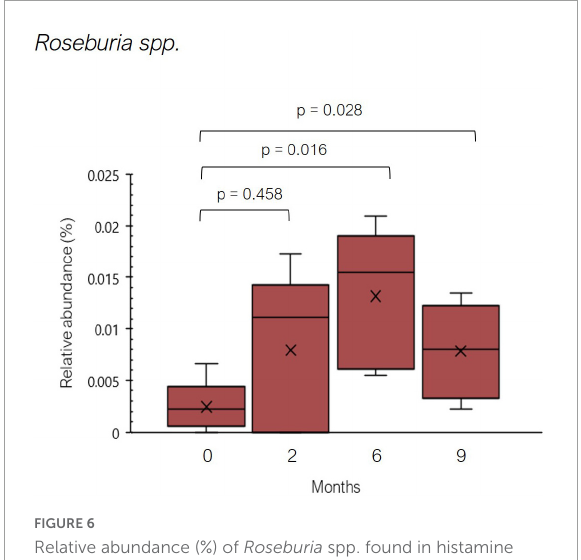
FIGURE6 Relative abundance (%) of Roseburia spp. found in histamine intolerant patients during the dietary treatment. Mean values are represented with an × . p < 0.05 indicates statically significant